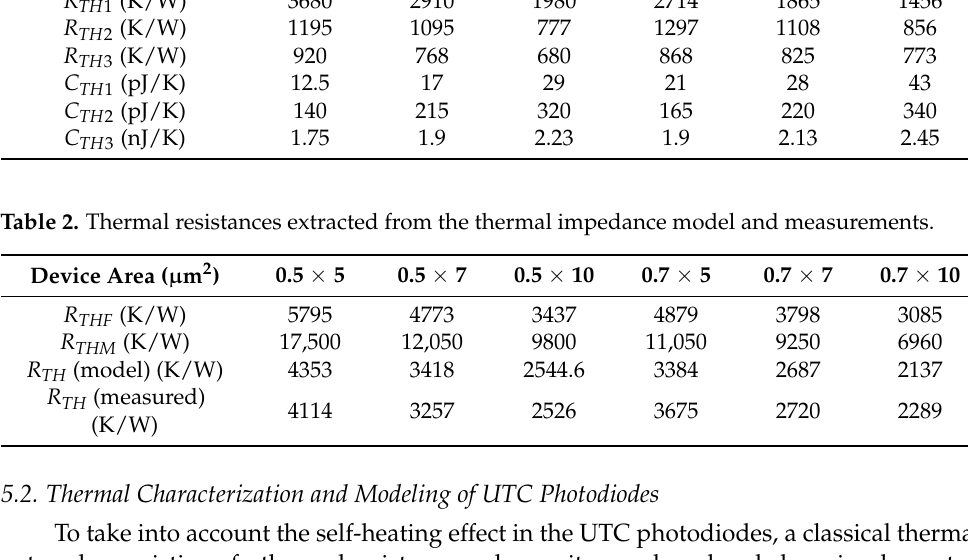
Table 2. Thermal resistances extracted from the thermal impedance model and measurements.